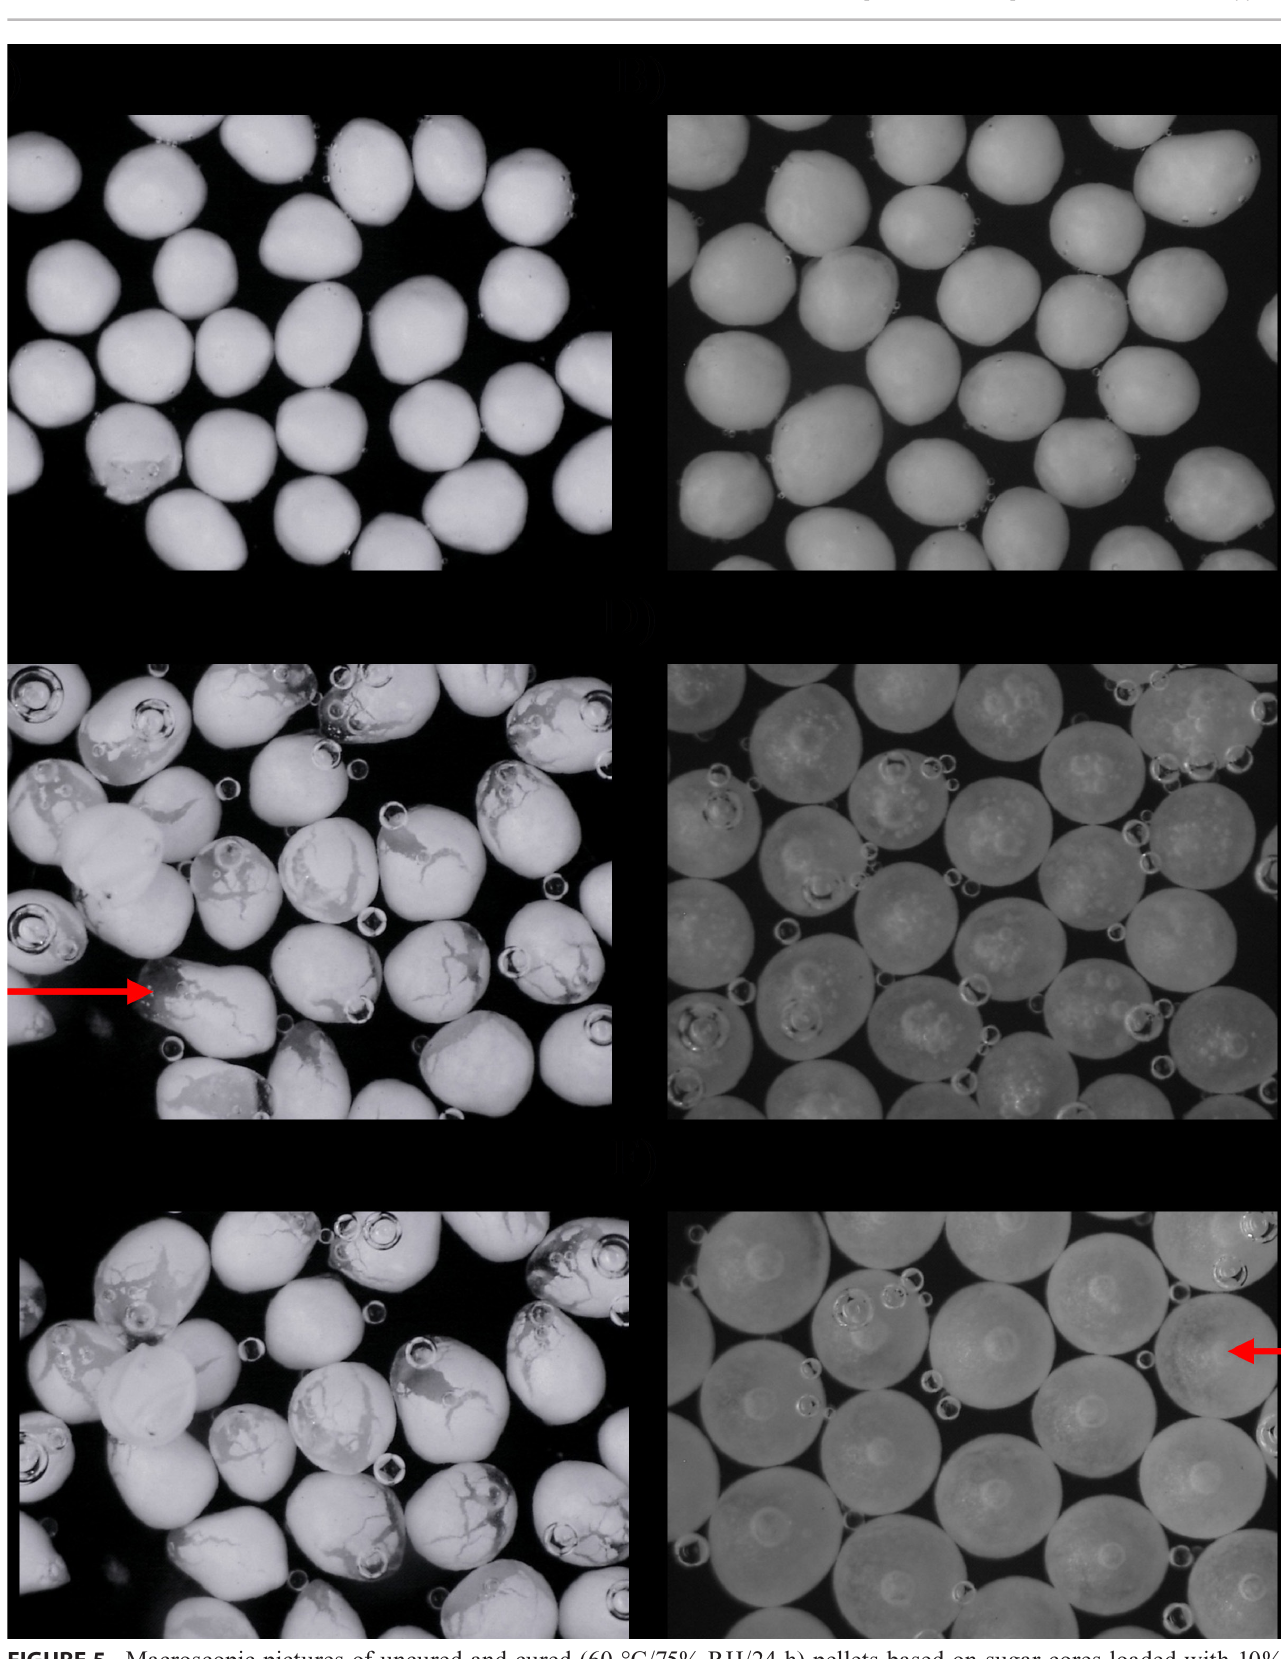
FIGURE 5 - Macroscopic pictures of uncured and cured (60 °C/75% RH/24 h) pellets based on sugar cores loaded with 10% propranolol HCl coated with Eudragit ® NE 30D using 35% talc as a function of time in 0.01 N